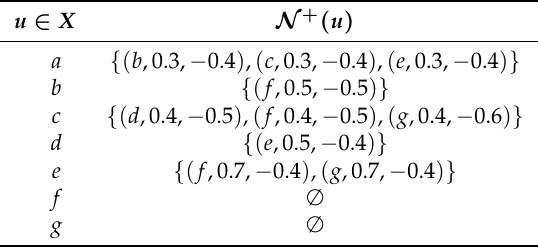
Table 2. Bipolar fuzzy inneighborhood.